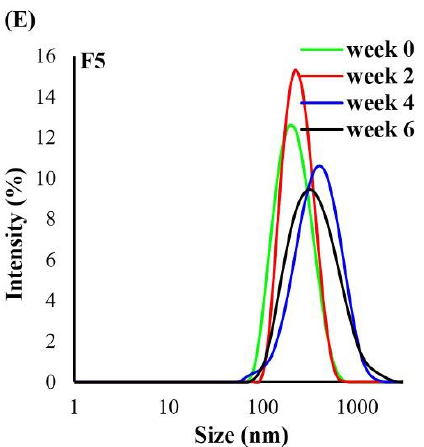
Figure 5. Size stability of nanoparticles. Particle size distribution of nanoparticles of ( A ) AgNPs in F0, and ( B – E ) Col-AgNPs in F2–F5 at week 0 – 6 .